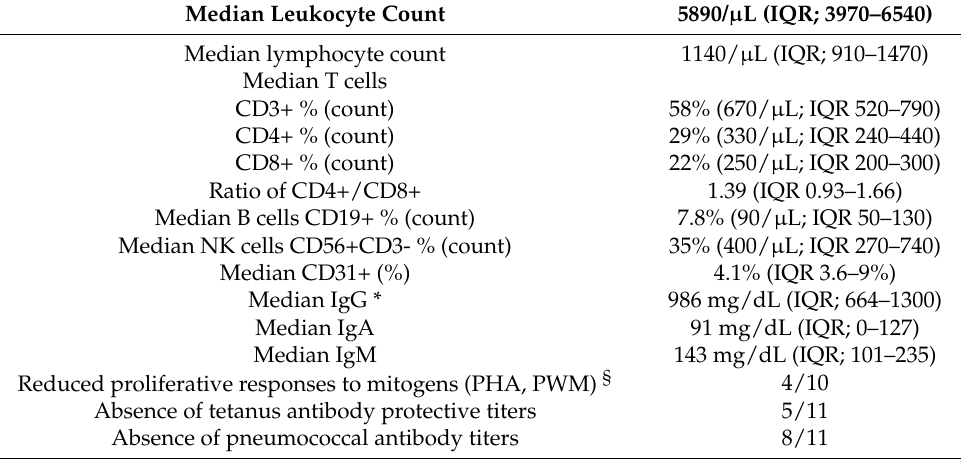
Table 1. Immunological studies of cases at the time of inclusion ( n =